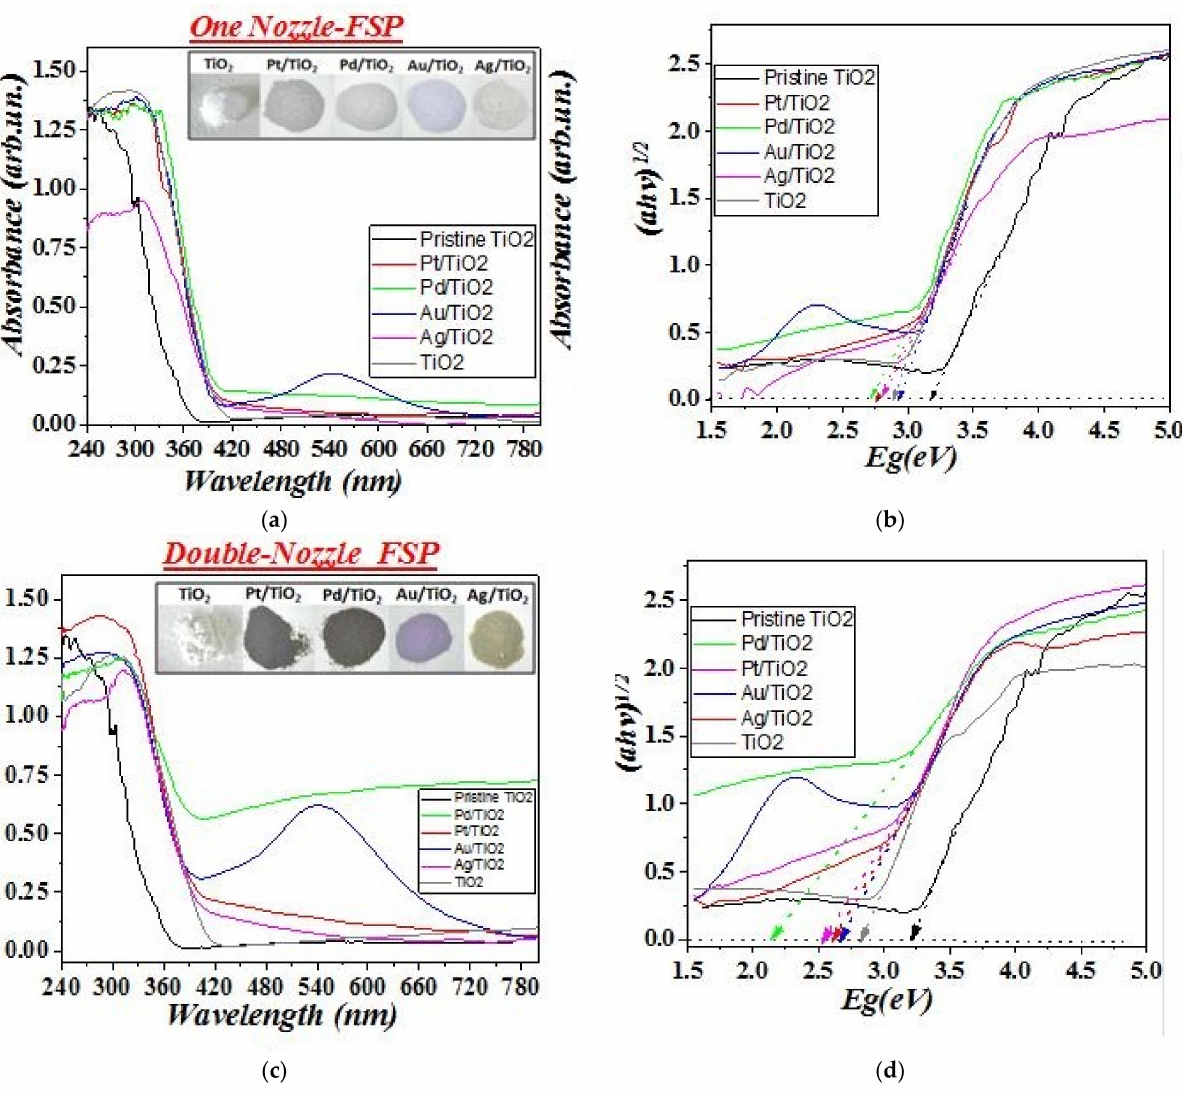
Figure 4. DRS-UV-Vis and Kübelka-Münk plots for ( a , b ) ON-FSP and ( c , d ) DN-FSP NM 0 -TiO 2 nanoparticles with 0.5%